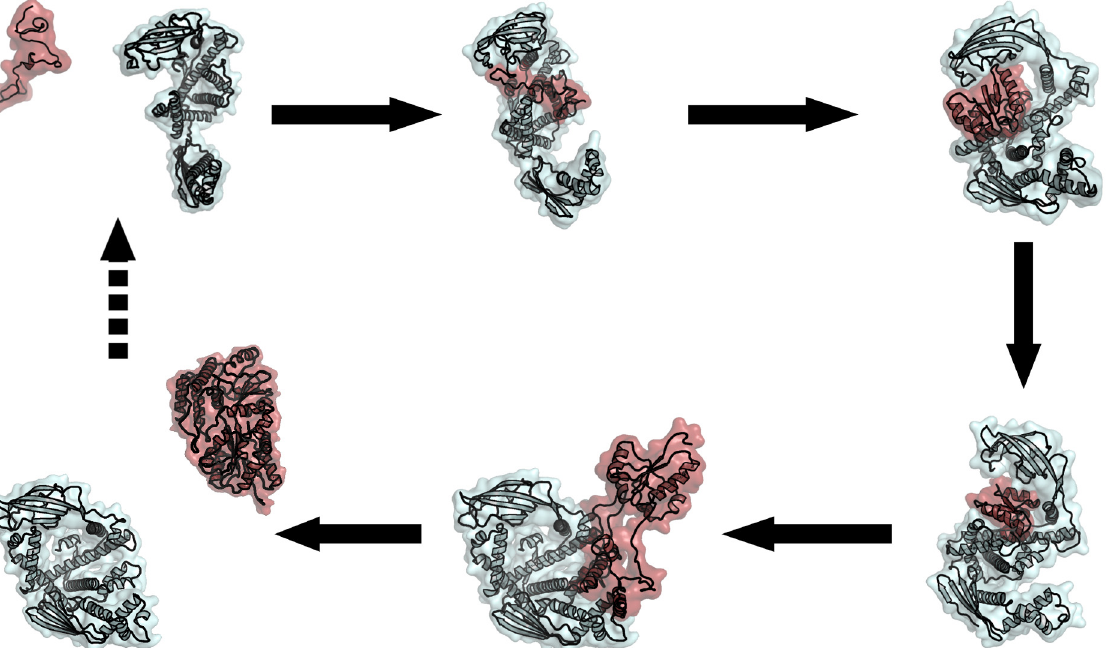
Fig 6. Cartoon representation of the folding of MBP in complex with TF. For each folding stage, a representative snapshot is shown, with MBP (and its partial folds) in pale red and TF in cyan. The schematic shows a series of events in the cycle, which starts with the interactions between folding intermediates of substrate proteins (MBP in this case) with TF and results in the fully folded substrate protein released from the TF at the end. This may involve more than one TF